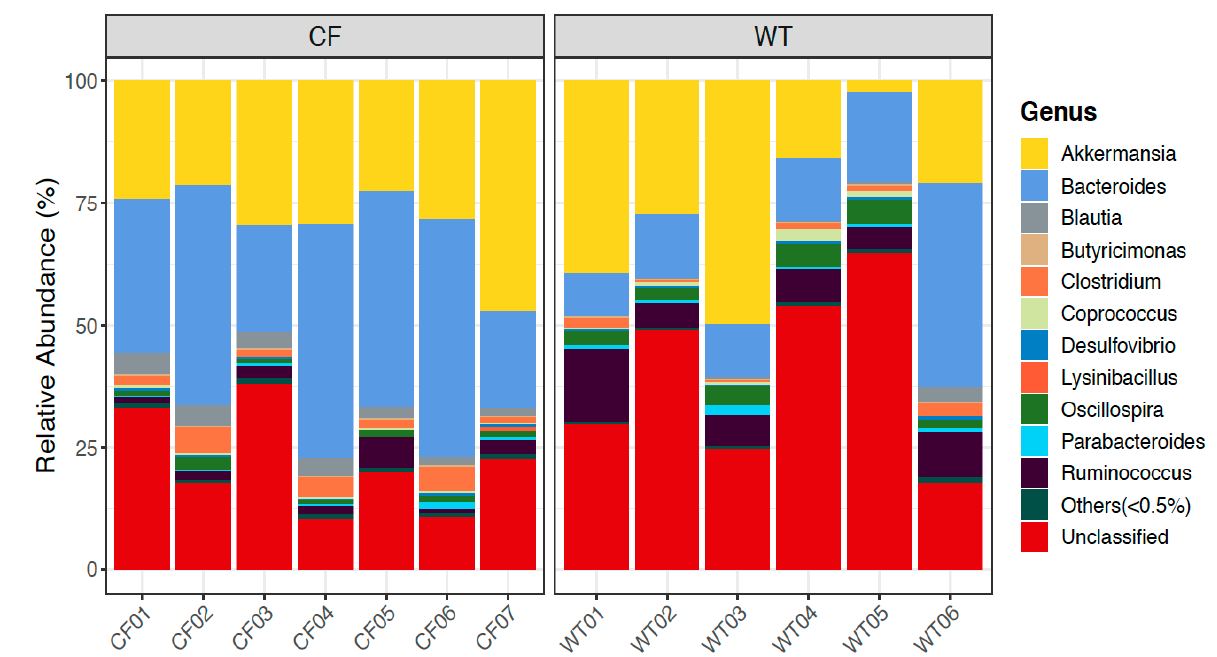
Figure 5. Relative abundance of bacterial genera in CF and WT rabbits. Table 2. Differentially abundant phyla and genera between CF and WT groups.